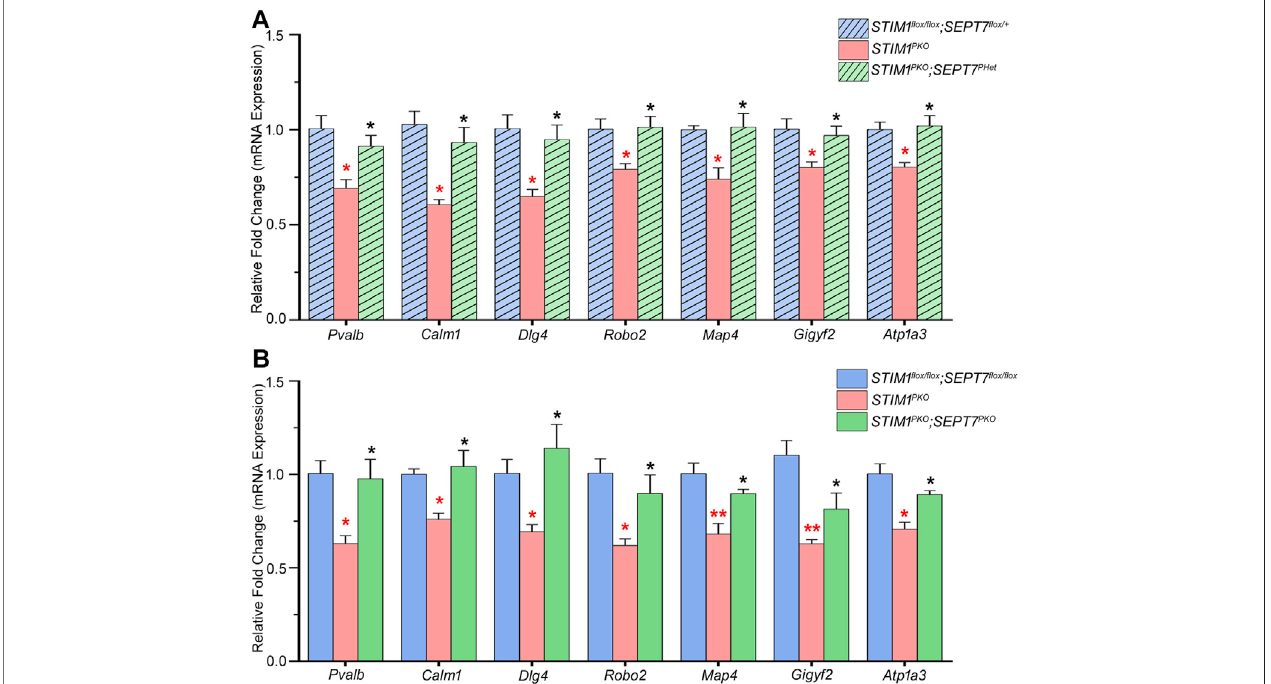
FIGURE3| Partialorcompletedeletion of SEPT7 canreverse theexpression ofasubsetofgenesthataredownregulatedby STIM1 knockoutinPurkinjeneurons. (A) Bar graph with relative fold changes in expression of the indicated genes in the indicated genotypes. Red asterisks above each bar represent statistically signi fi cant change between STIM1 PKO (pink bars) and the control genotype STIM1 fl ox/ fl ox ; SEPT7 fl ox/+ (light blue bars). Black asterisks above each bar represent statistically signi fi cant change between STIM1 PKO (pink bars) and the experimental genotype, STIM1 PKO ; SEPT7 PHet (light green bars) . (B) Bar graph of relative gene expression changes in the indicated genotypes. Red asterisks over each bar represent statistically signi fi cant change between STIM1 PKO (pink bars) and the control genotype STIM1 fl ox/ fl ox ; SEPT7 fl ox/ fl ox (blue bars) . Black asterisks above each bar represent a statistically signi fi cant change between STIM1 PKO (pink bars) and STIM1 PKO ; SEPT7 PKO (greenbars) . Foldchangeswerenormalizedto GAPDH .Dataarepresentedasmean ± SEM,* p < 0.05,** p < 0.01;one-wayANOVAwithposthoc Tukey ’ s test. All measurements are taken by qRT-PCR of cDNA prepared from RNA isolated from microdissected Purkinje layers ( n (cid:1) 3 mice for all groups and n (cid:1) 4